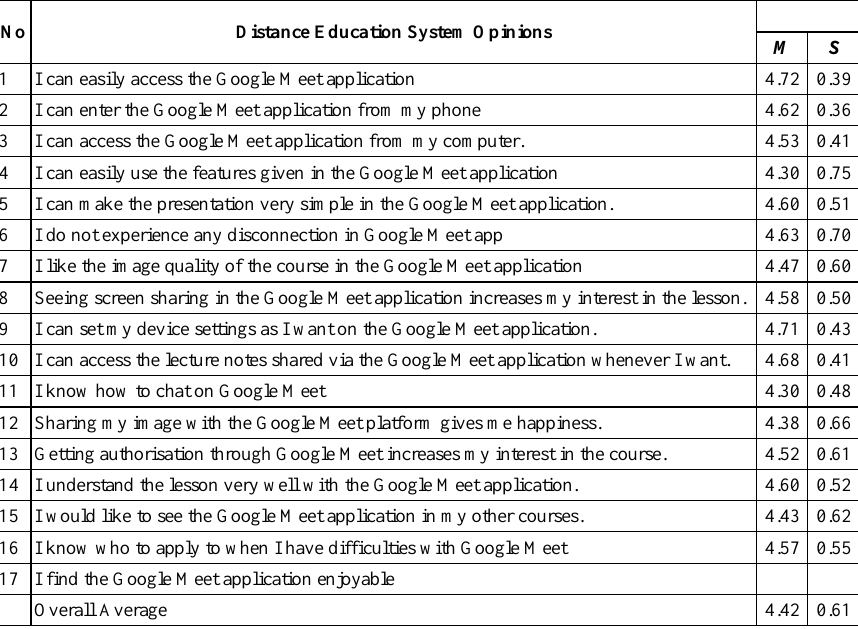
Table 6. pinions of university students on the Google Meet